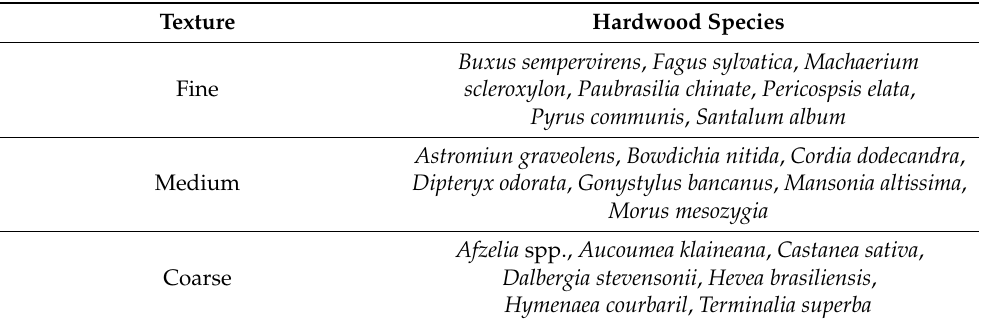
Figure 3. Hardwood texture (longitudinal and transverse sections). ( A 1 , A 2 ): fine texture ( Pyrus communis ); ( B 1 , B 2 ): medium texture ( Baillonella toxisperma ); ( C 1 , C 2 ): coarse texture ( Terminalia superba). Table 5. Examples of species for fine, medium, and coarse textures (these texture types are commonly reported in literature, for instance in [41]).